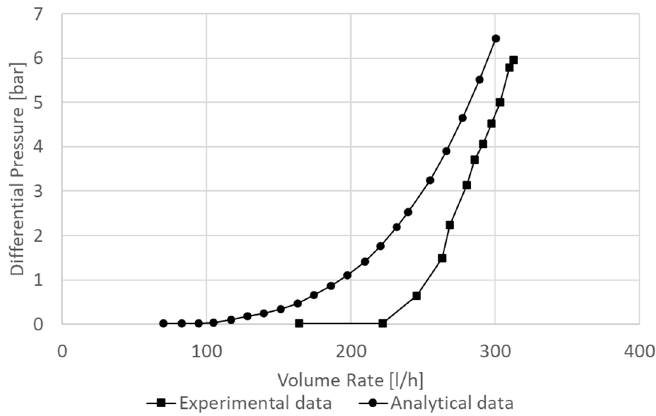
Figure 7. Experimental and analytical water data in the RCP valve designed by Statoil and improved by Askvik and Johannessen